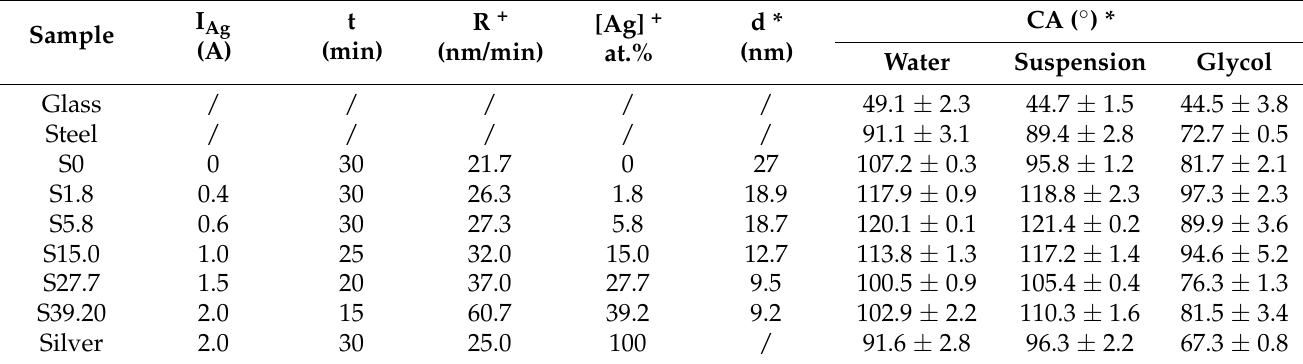
Table 1. Silver target current (I Ag ), deposition time (t), deposition rate (R), silver content ([Ag]), grain size (d) and contact angle (CA) of the